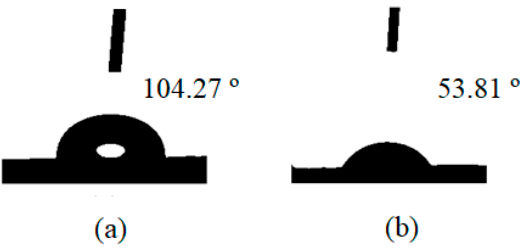
Figure 5. Water contact angle ( θ ) measurements: ( a ) bare LLDPE and ( b ) 8%- ZT@LLDPE.